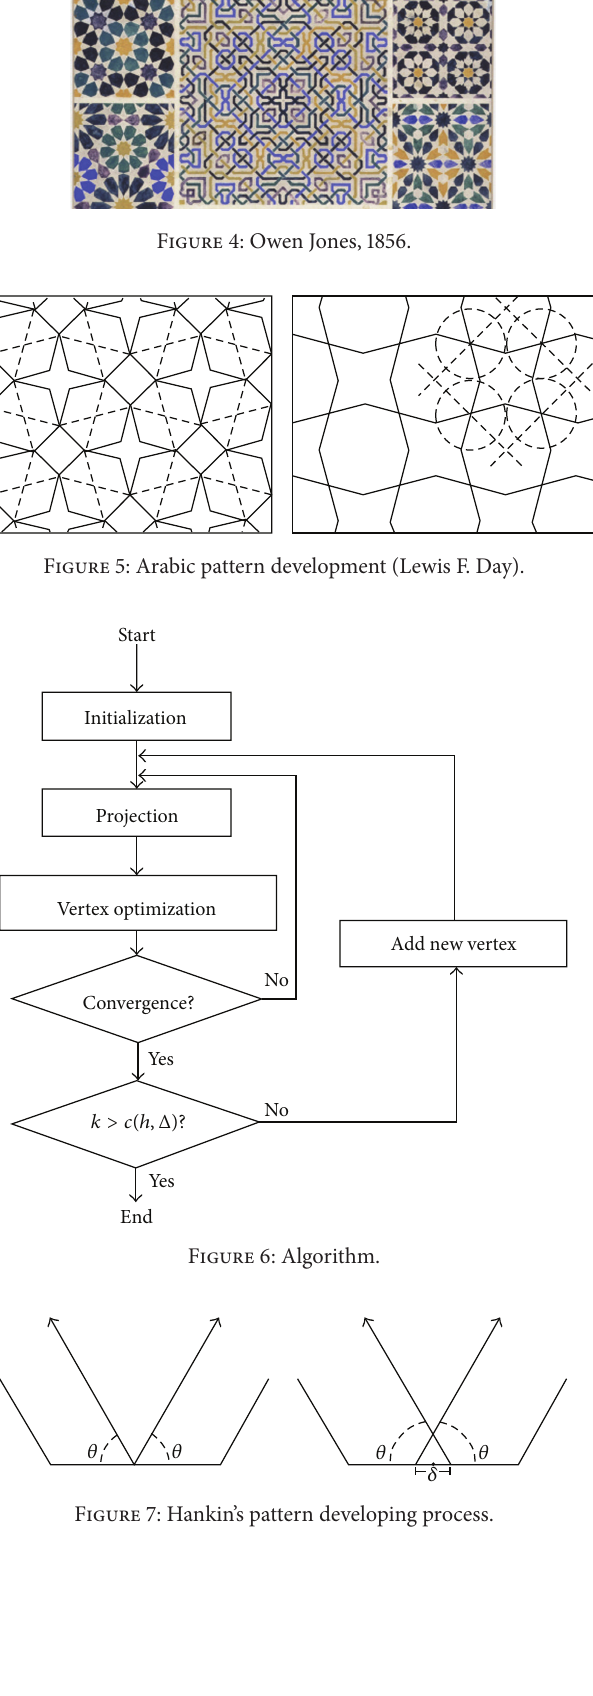
Figure 7: Hankin’s pattern developing